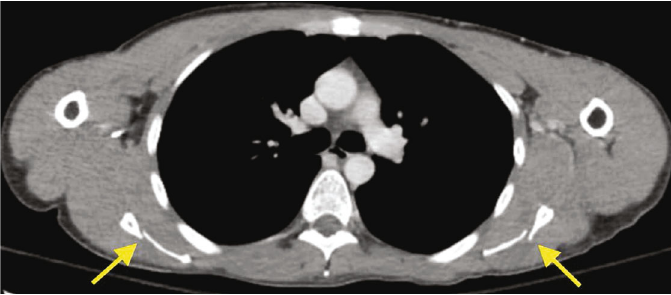
Figure 2: Computed tomography (CT) imaging demonstrating bilateral scapular body